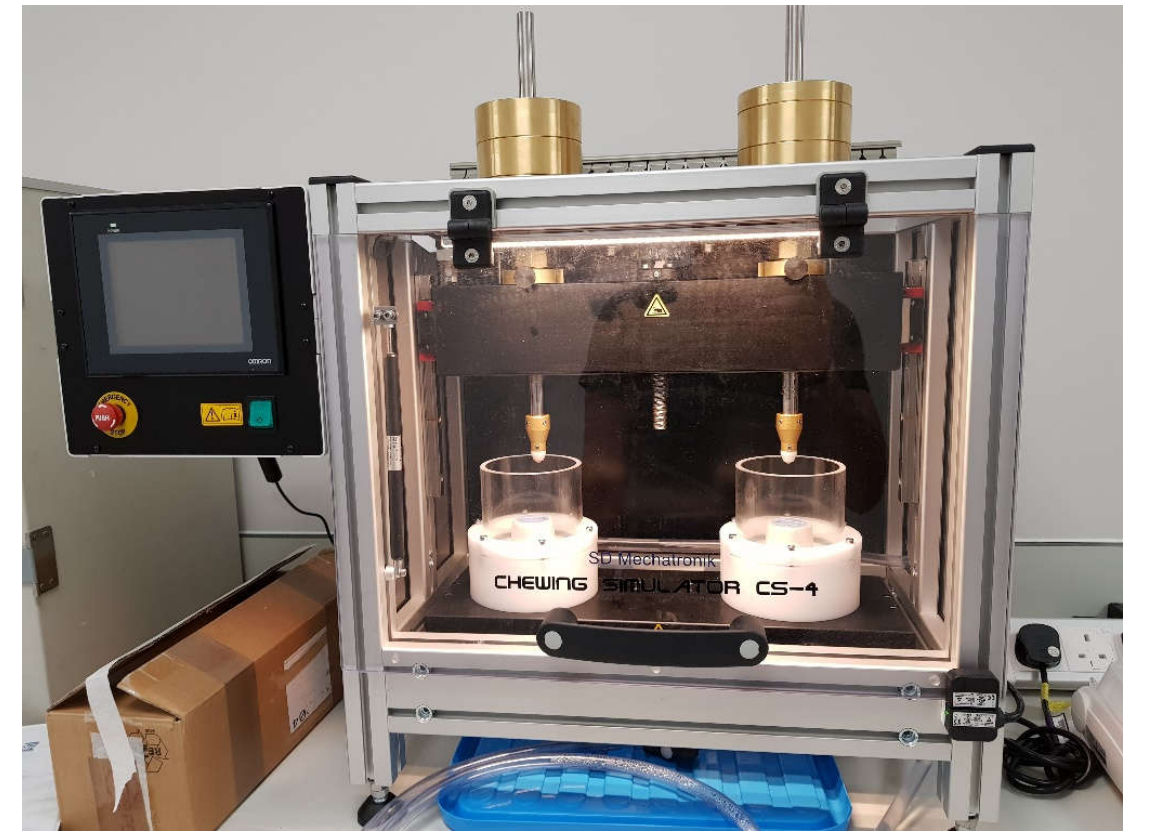
Figure 1. Chewing simulator CS-4.2.